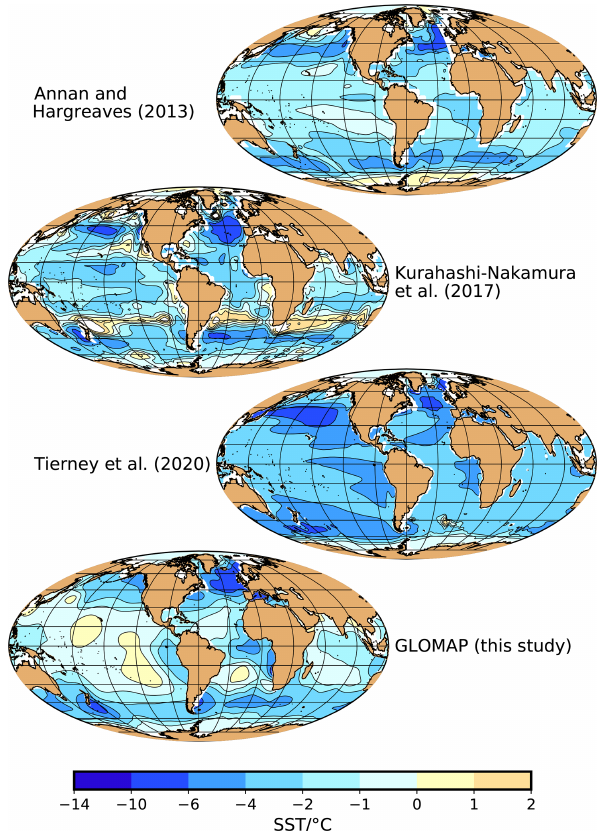
Figure 7. Annual-mean near-sea-surface temperature anomalies for the LGM according to the reconstructions by Annan and Hargreaves (2013), Kurahashi-Nakamura et al. (2017), and Tierney et al. (2020) on the one hand and GLOMAP on the other